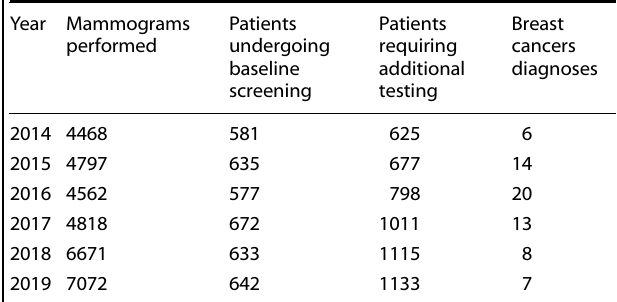
Table 2. Baseline screening, additional testing, and number of cancers identi fi ed per year.